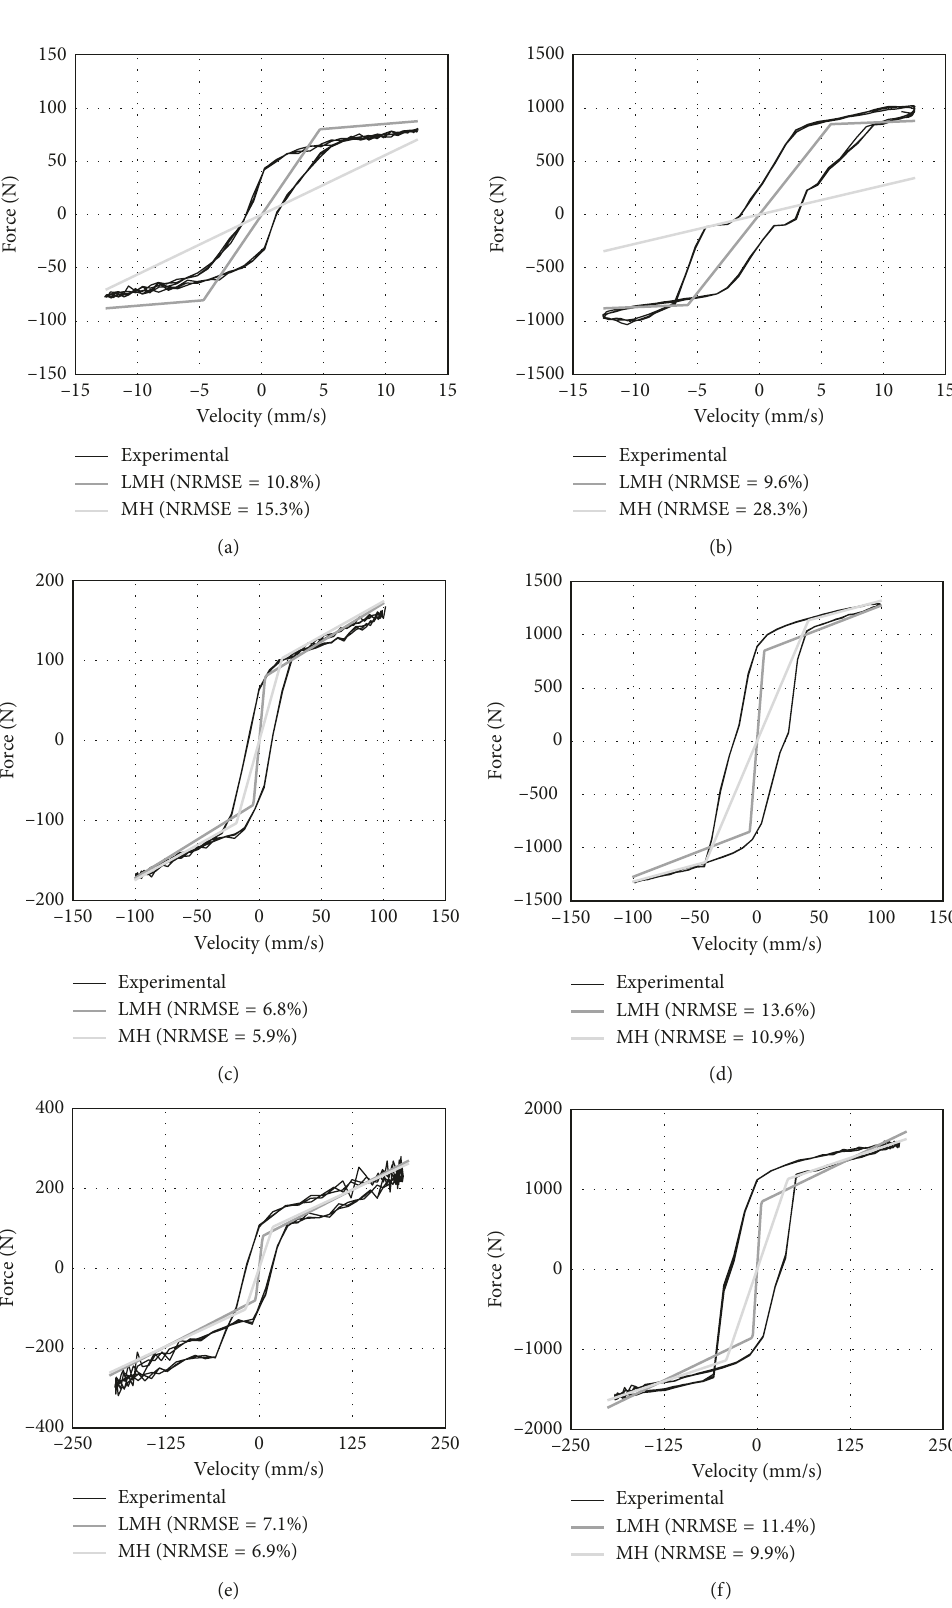
1A; (e) high velocity without intensity; (f) high (cid:31)